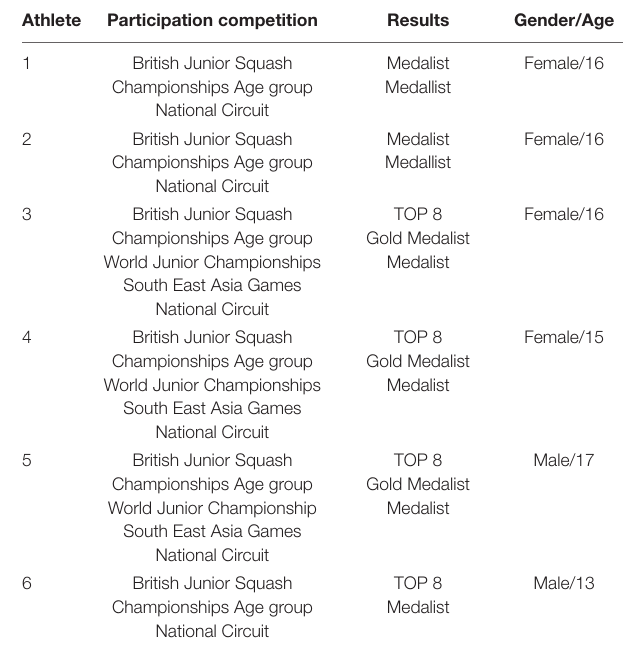
TABLE 1 | Participants demographic information and championships